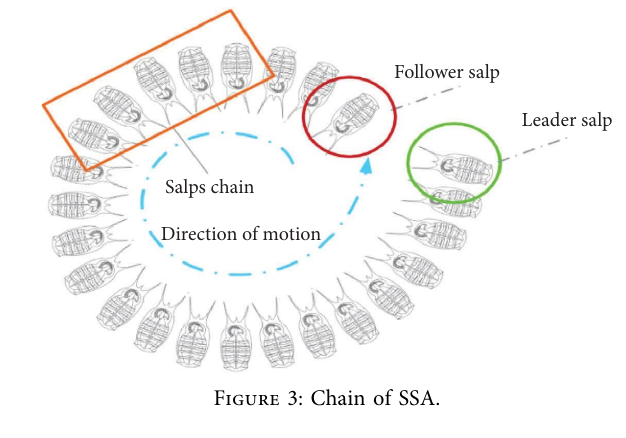
Figure 3: Chain of SSA.